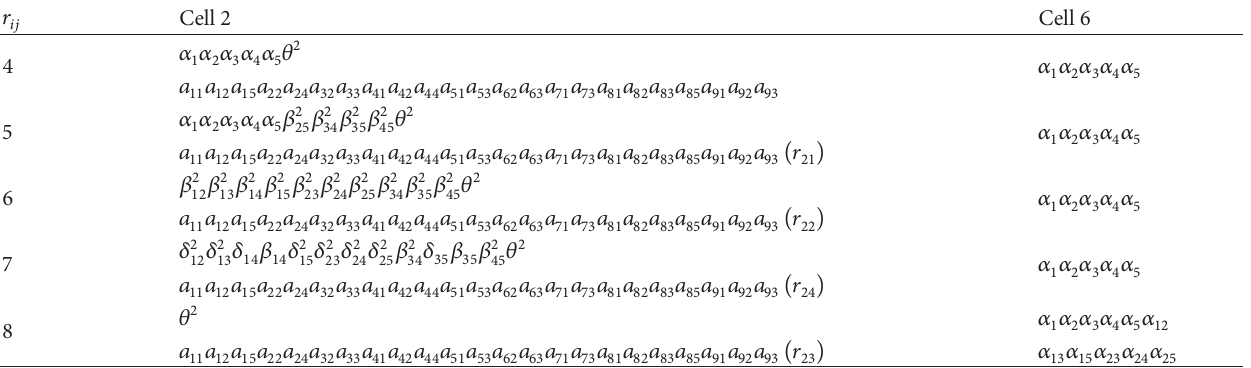
Table 4: Generation of frequent